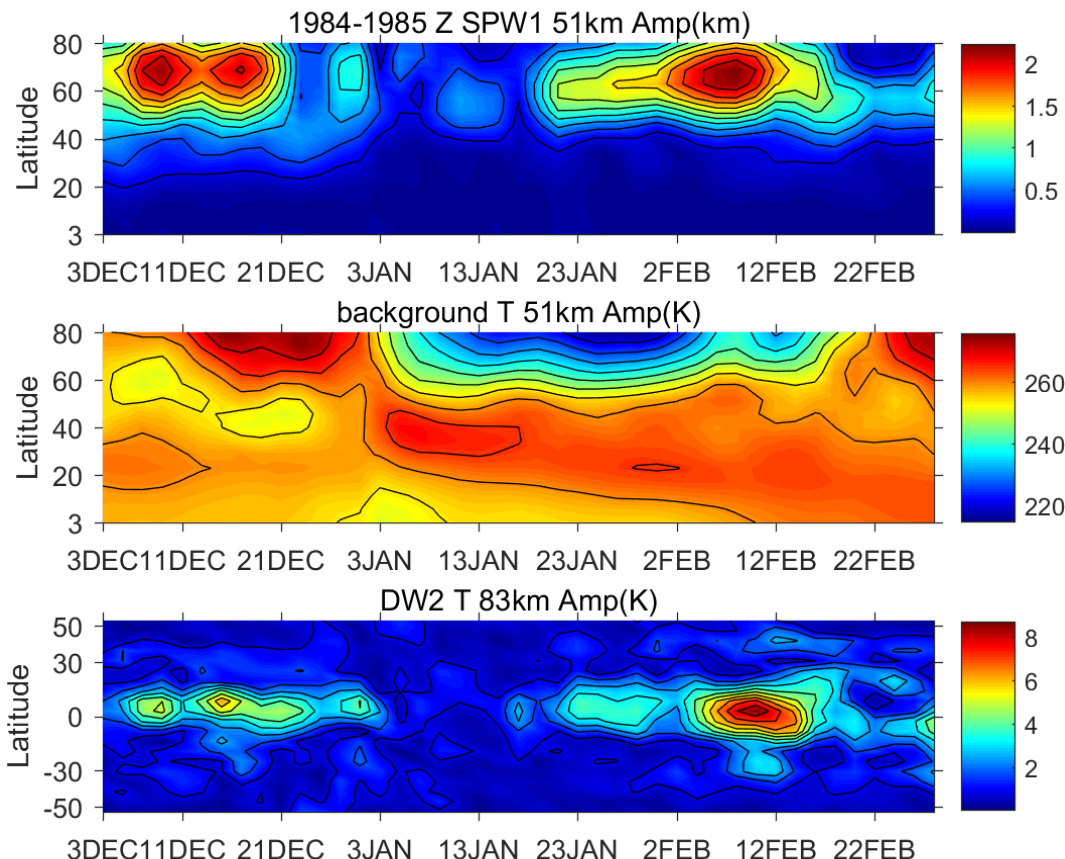
Figure 6. Same as Figure 1, but for the winter of 1984–1985: The highest correlation between SPW1 and DW2.